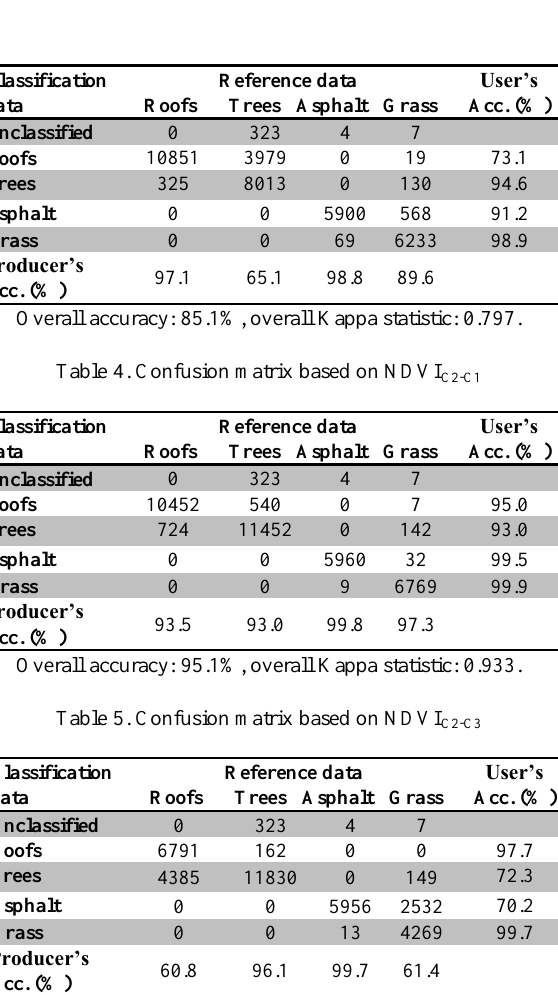
Table 6. Confusion matrix based on NDVI C1-C3